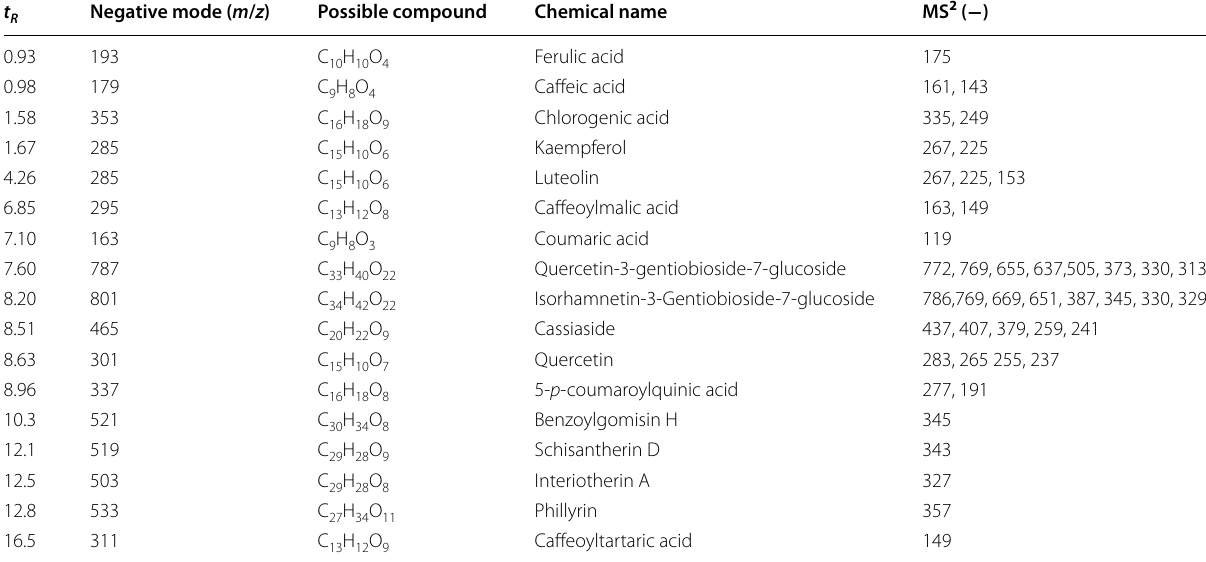
Table 3 List of constituents based on the of HPLC analysis of Spinacia oleracea L extract t R Negative mode ( m / z ) Possible compound